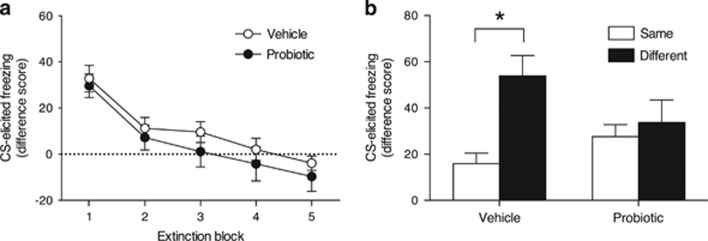
Mean (±s.e.m.) CS-elicited freezing during (a) extinction and (b) test for vehicle- and probiotic-exposed maternally separated (MS) infant rats. Only vehicle-exposed MS rats demonstrated the renewal effect, that is, higher freezing in the different context (n=11) compared with the same context (n=11). Probiotic-exposed MS rats exhibited low freezing in both the same context (n=15) and the different context (n=14). *P<0.05.